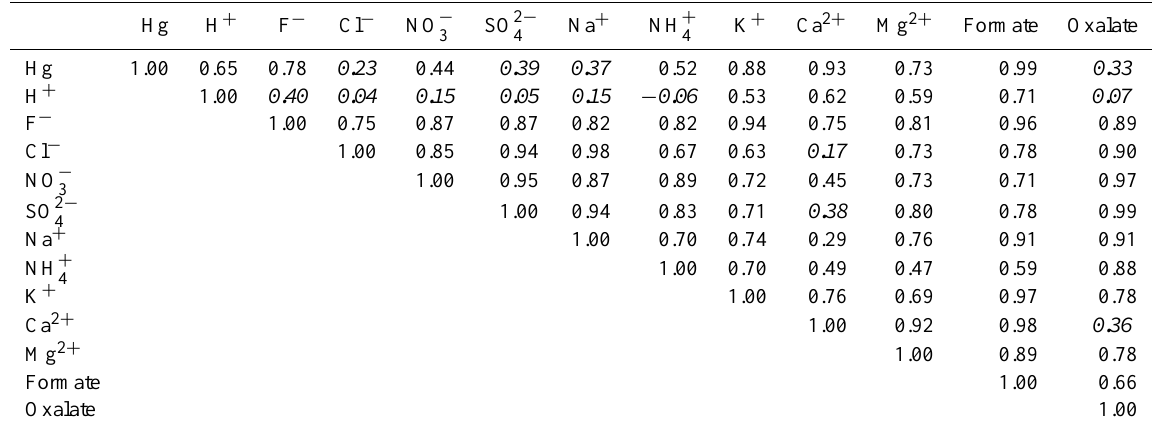
Table 3. The correlation coefficients between mercury and major ions in rainwater (italics show p >0.05).